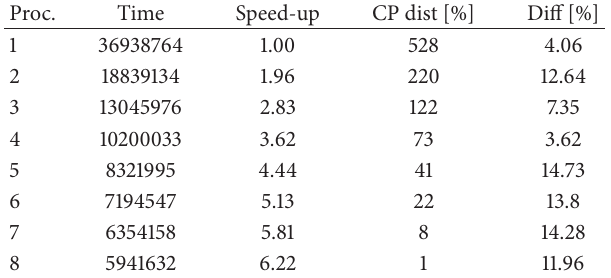
Table 14: Improvement summary. Table 15: Averaged time of the final improvement.